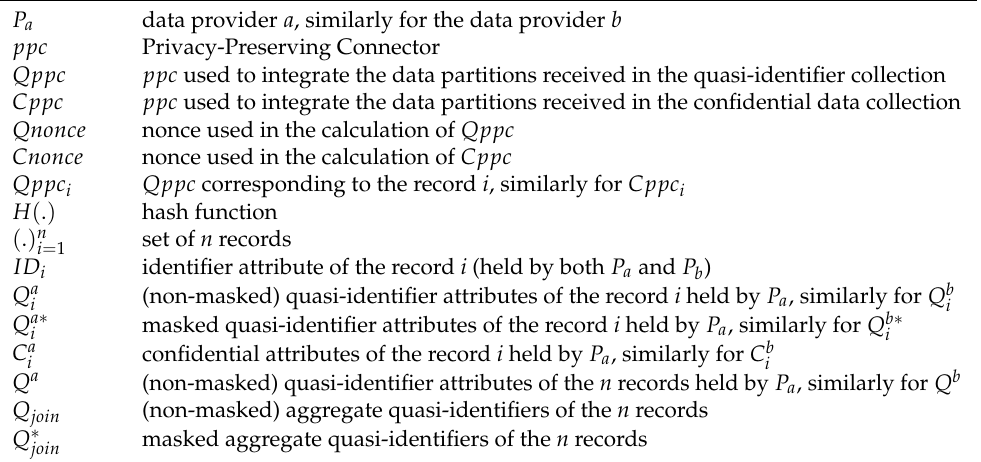
Table 2. List of symbols and mathematical notations used in the anonymization and integration